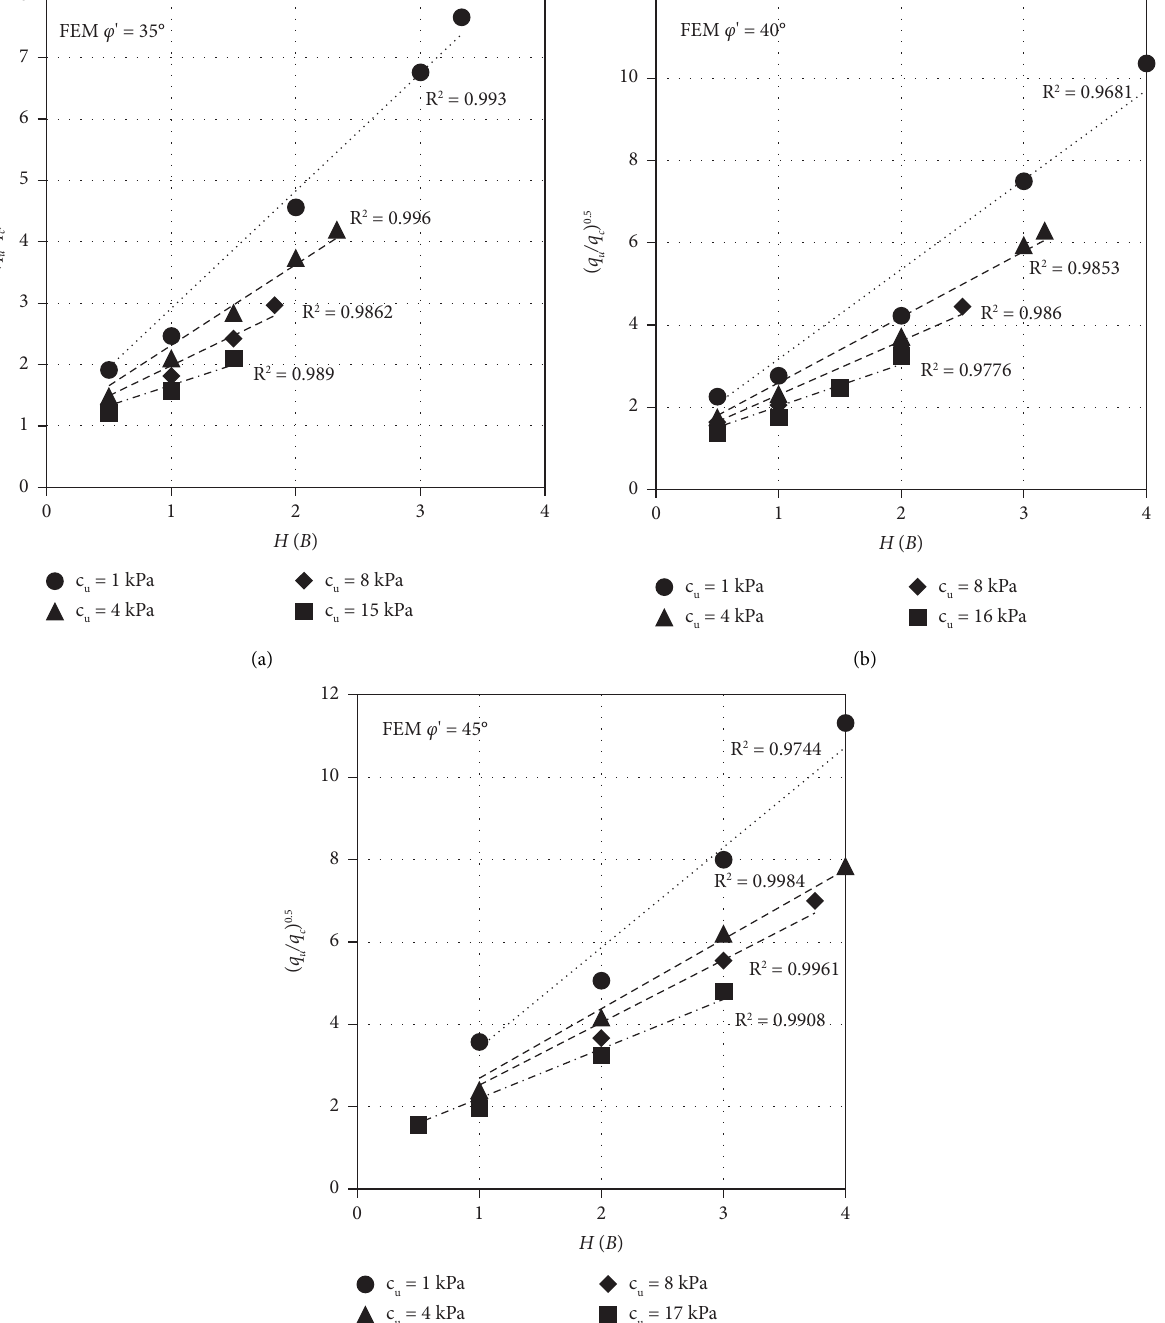
Figure 8: ( q q ) 0 . 5 versus H/B for an unstabilised granular layer (data source: Park and Park [37]): (a) FEM ϕ ′ � 35 ° , (b) FEM ϕ ′ � 40 ° , and u / c (c) FEM ϕ ′ � 45 °